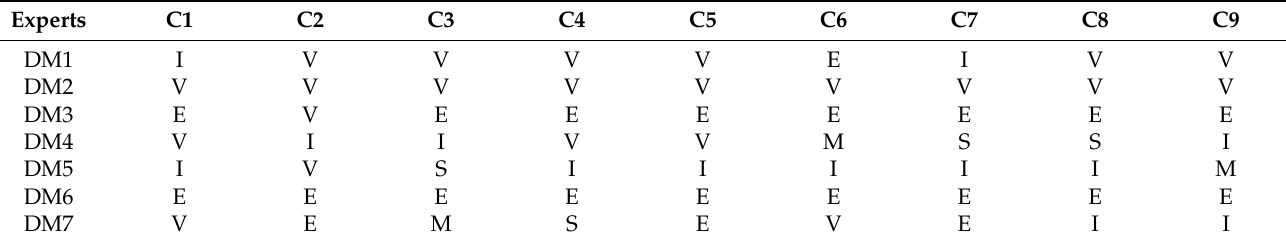
Table 8. The linguistic assessments of the experts on the